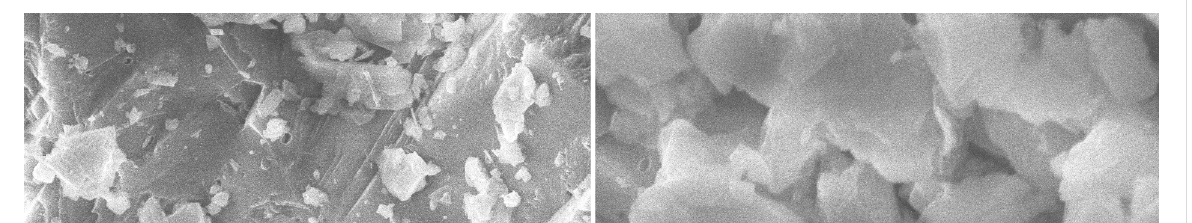
Figure 4: Raman spectrum of the NDL catalyst.